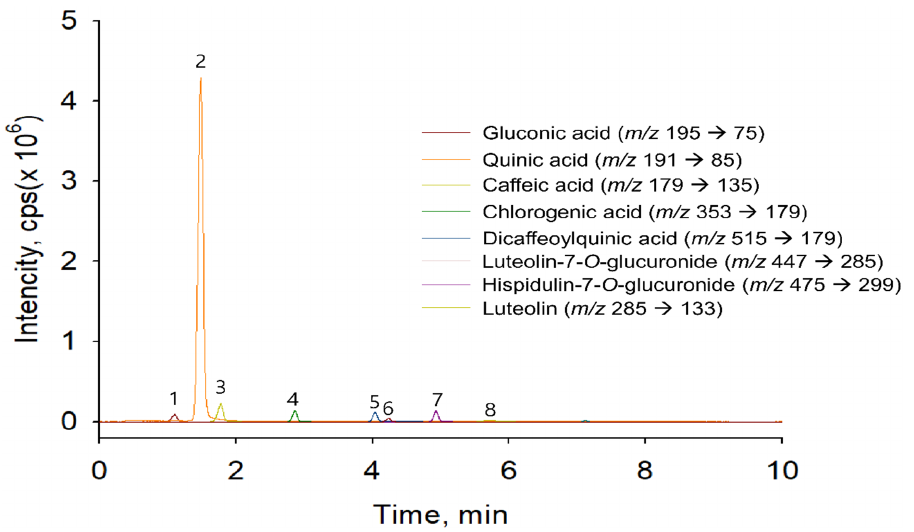
Figure 5. Effects of EAW on the activation of AMPK signaling in epididymis adipose tissues. Epididymis adipose tissue was homogenized, and the lysates were subjected to western blot analysis for p-AMPK, p-ACC, and CPT1. The intensity of each band was quantified using ImageJ. Values and is expressed as mean ± SD ( n = 3). Different lowercase alphabets indicate that differences between means were considered statistically significant when p < 0.05. ND, normal diet mice